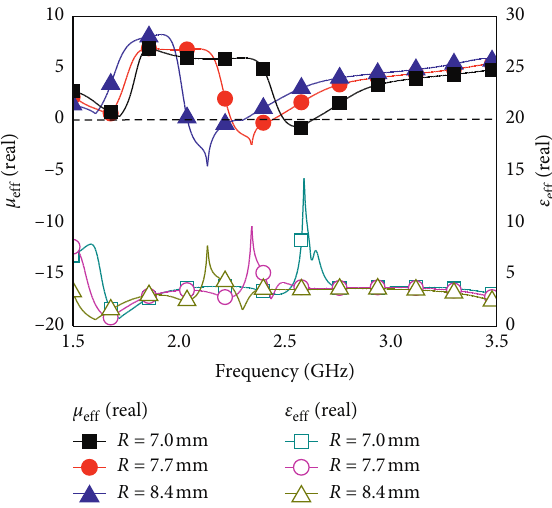
Figure 6: Effective response of SRR with different R .